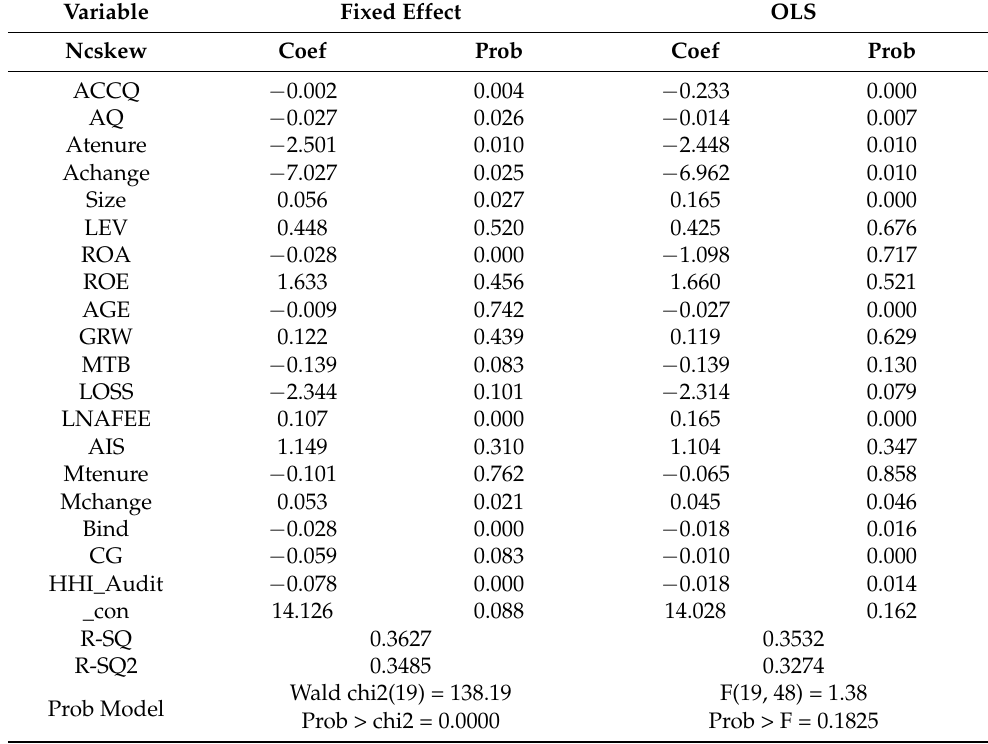
Table 12. The results of the model for